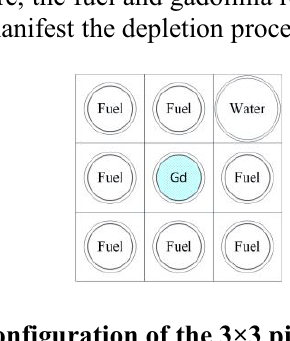
Figure 3. Tables of CPs from the 5 th to 11 th rings of the No.3 pin for the gadolinia rod in VERA 2O.